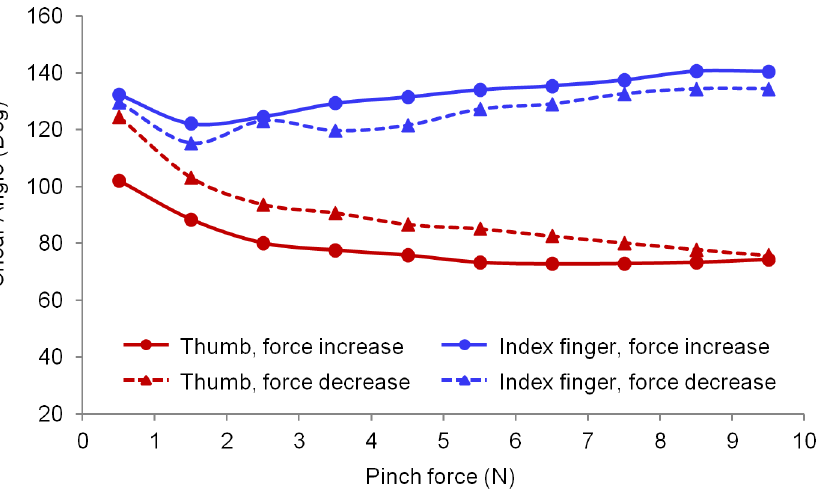
Figure 6. Projection angle for the thumb and index finger. Each data point represents the average of SA for all the trials within the specified 1- N force interval.